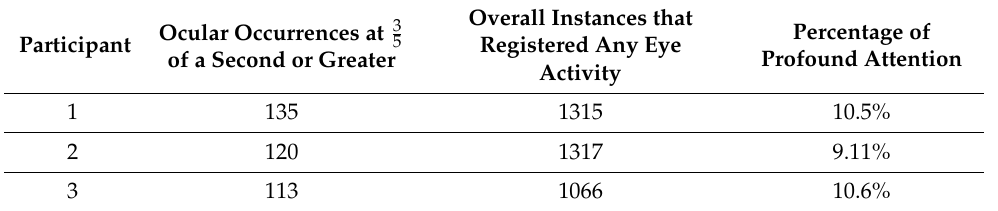
Table 7. Percentage of profound attention per participant.